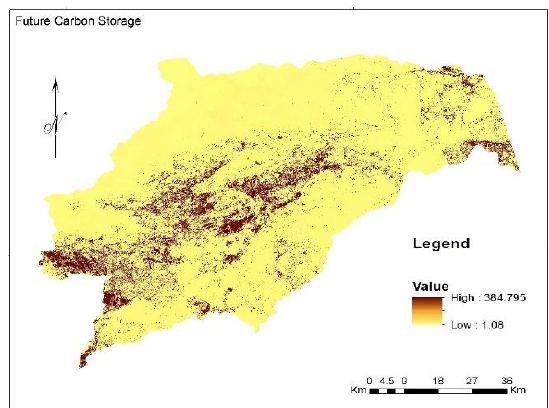
Figure 4: Two maps showing the currently stored carbon and the future projected carbon storage in